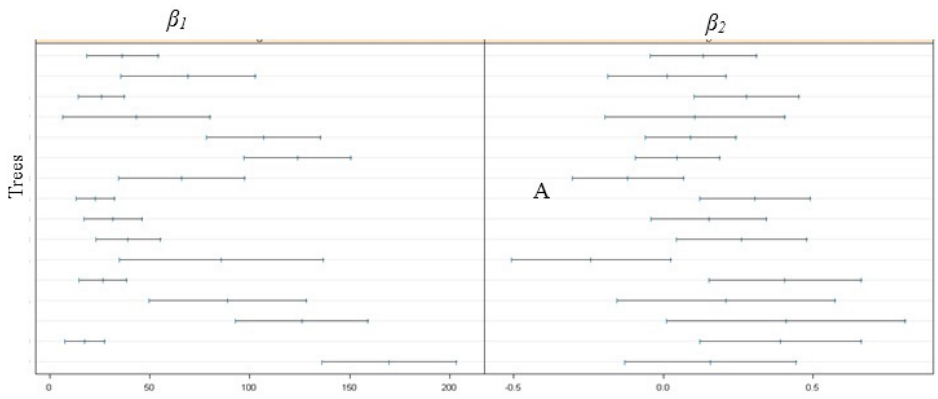
Figure 2. Con fidence intervals of parameters β 1 and β 2 for individual Chinese pine trees